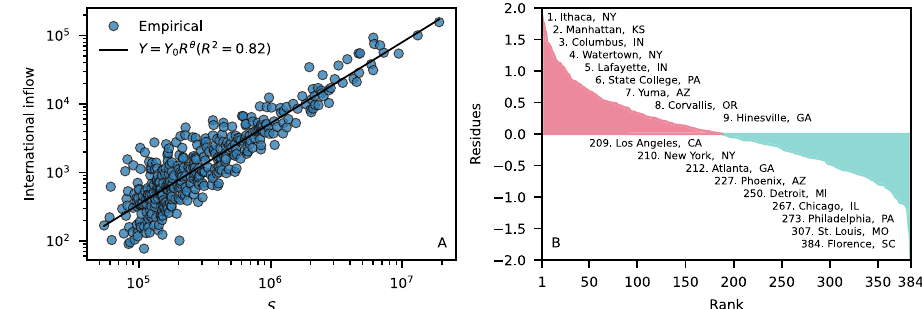
Fig. 7 | International in fl ow scales superlinearly with city size. Panel ( A ) shows the number of international immigrants as a function of the city size S for the 384 U.S. metro areas. The performance of the model Y = Y 0 S θ , in which θ =1.19 (95% CI